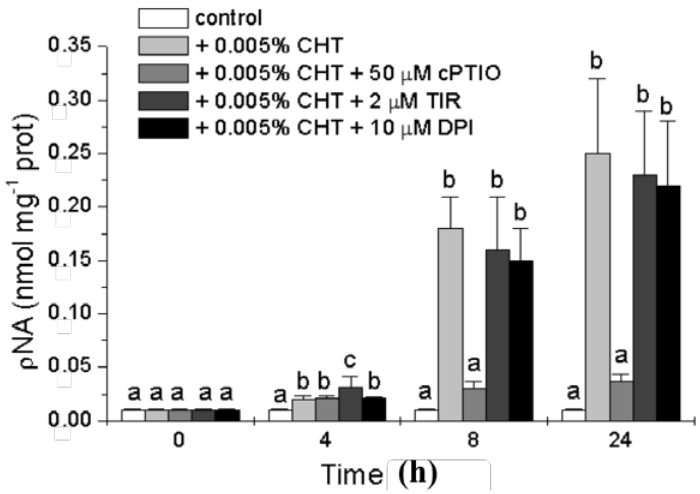
Figure 4. Effect of CHT, cPTIO, Tiron, and DPI on caspase-3-like activity. Mean values ± SD ( n ≥ 6) are presented. Different letters indicate significant differences among treatments at each experimental time (Tukey HSD test, p ≤ 0.05).